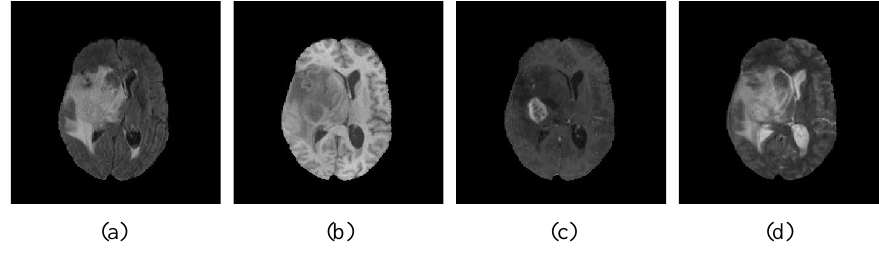
Figure 5. MRI images in different modalities: ( a ) Flair, ( b ) T1, ( c ) T1ce, and ( d )